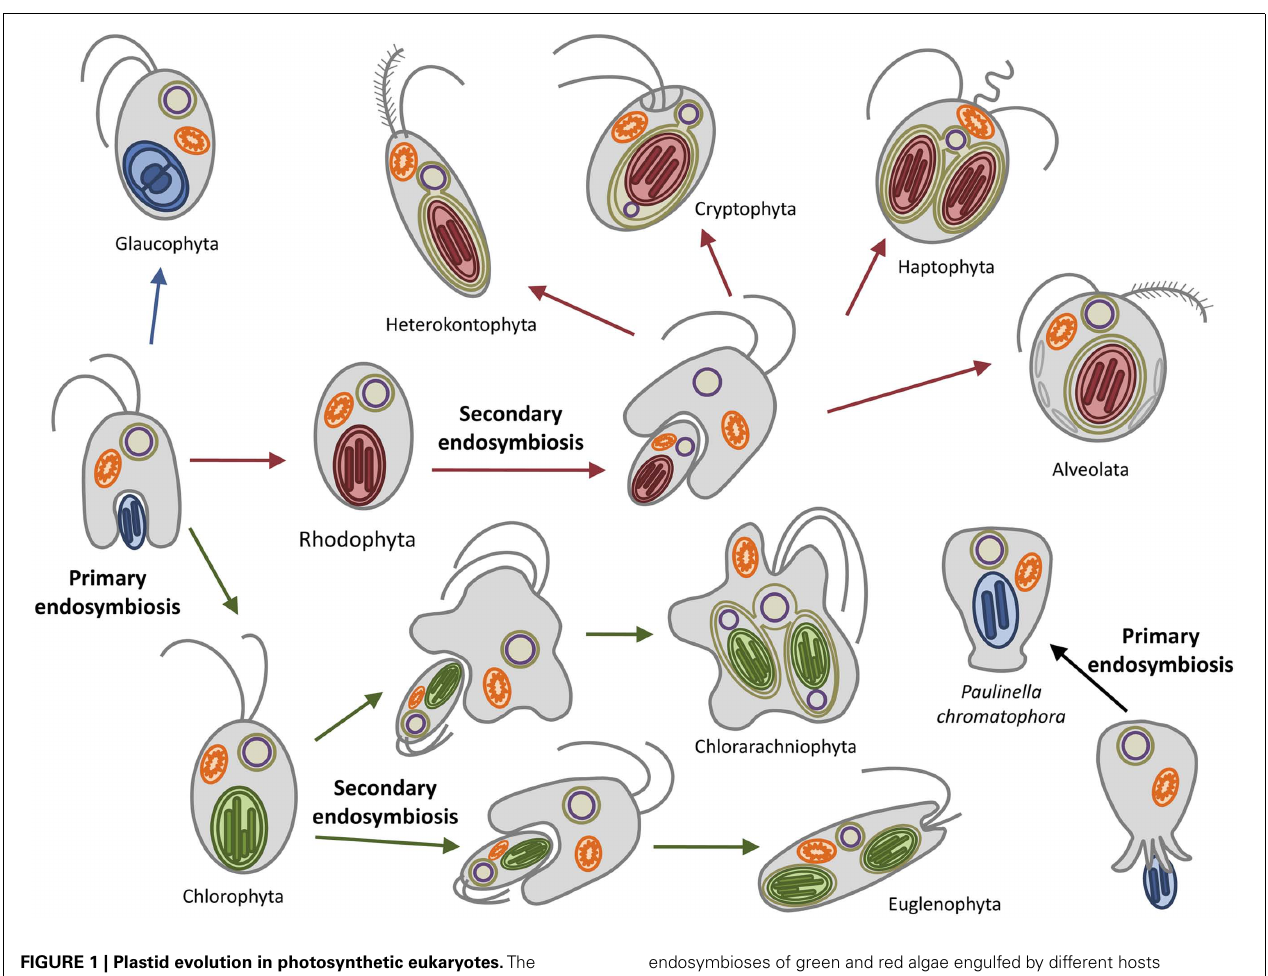
FIGURE 1 | Plastid evolution in photosynthetic eukaryotes. The uptake of a cyanobacterium resulted in a photosynthetic plantae ancestor which subsequently diverged in the three lineages containing primary plastids: the chlorophytes (including the land plants), the rhodophytes, and the glaucophytes.The subsequent secondary